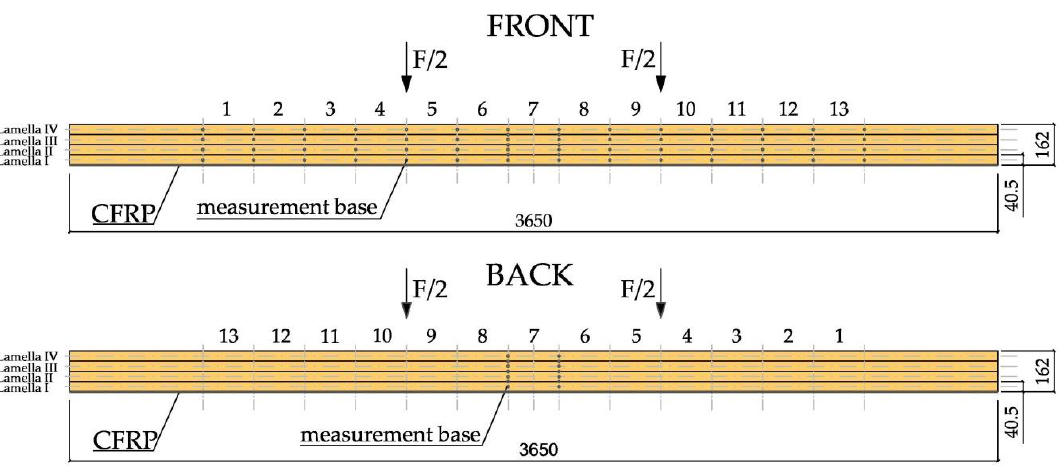
Figure 4. Arrangement of measuring bases along the entire length of CFRP-reinforced beams [dimensions in mm].